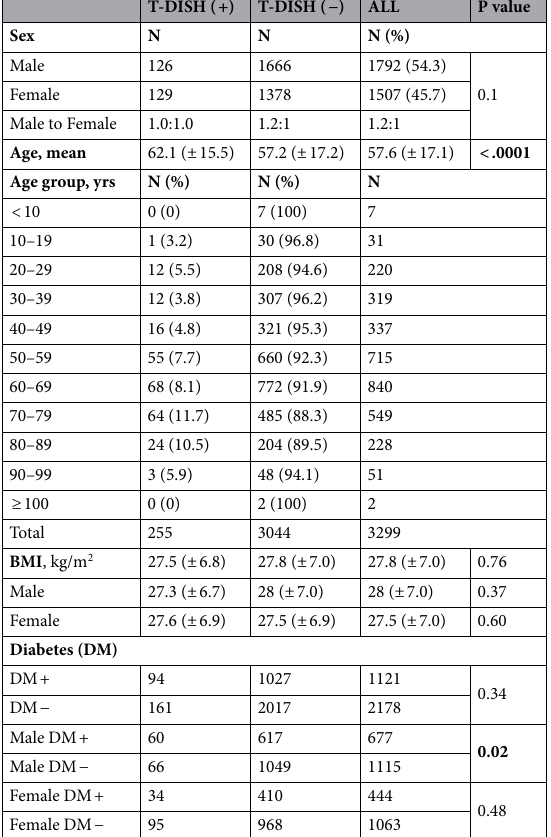
Table 2. Distribution of study population according to T-DISH ( +) or ( −). T-DISH thoracic diffuse idiopathic skeletal hyperostosis; N number, BMI Body mass index.